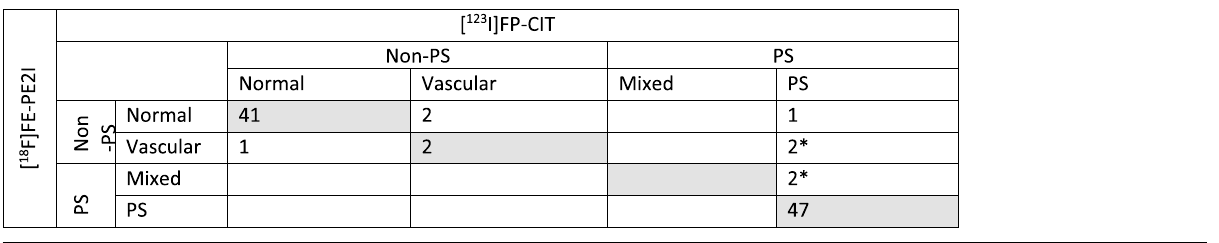
PS Parkinsonian